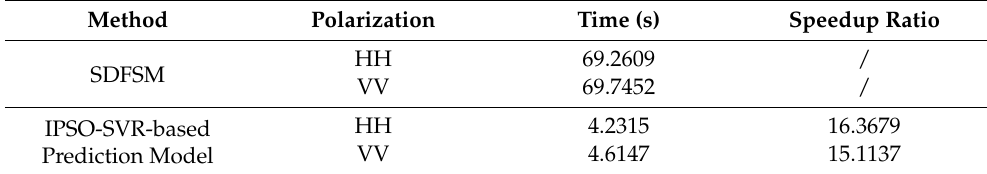
Table 3. Statistical results of simulation time and speedup